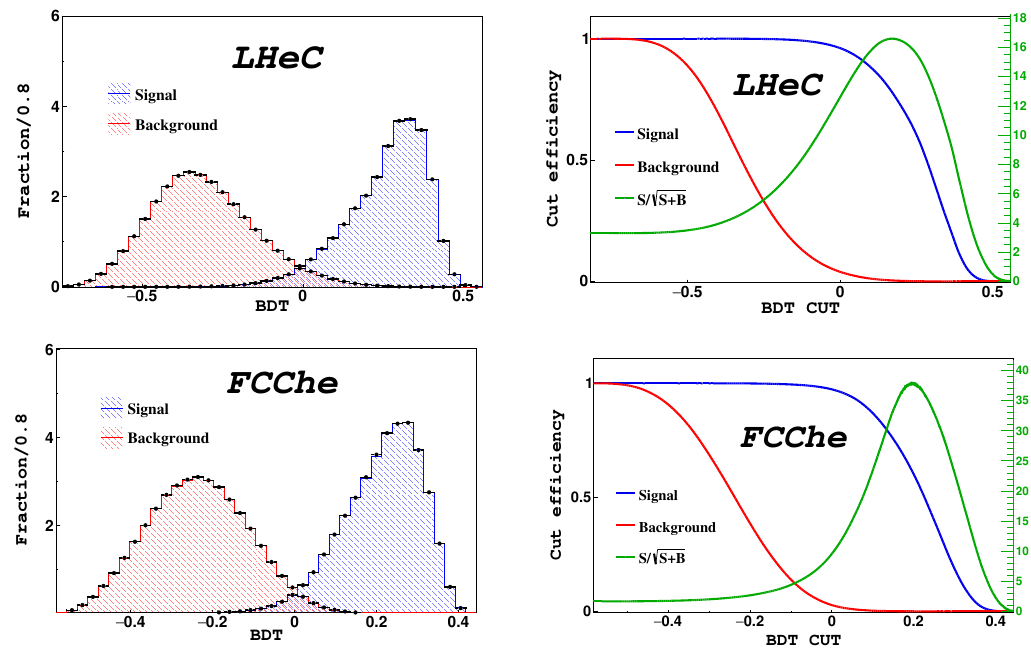
Figure 4 . All the plots use M N = 400 GeV and (cid:18) e = (cid:18) (cid:22) = 0 : 01, j (cid:18) (cid:28) j = 0. Upper left : BDT distri- bution at the LHeC for both train and test samples superimposed. Bottom left : BDT distribution at the FCC-he for both train (black dotted distributions) and test ((cid:12)lled blue and red distributions) samples superimposed for both signal and background events. Upper right : Cut e(cid:14)ciency at the p LHeC with BDT cut (cid:21) 0 : 17 one can get S= S + B = 16 (cid:27) with number of signal events = 330 and background events = 64. The cut e(cid:14)ciency for the signal is 0 : 78 and for the background 0 : 004. p Bottom right : Cut e(cid:14)ciency at the FCC-he with BDT cut (cid:21) 0 : 189 one can get S= S + B = 37 : 87 (cid:27) with number of signal events = 1743 and background events = 376. The cut e(cid:14)ciency for the signal is 0 : 6 and for the background 0 :